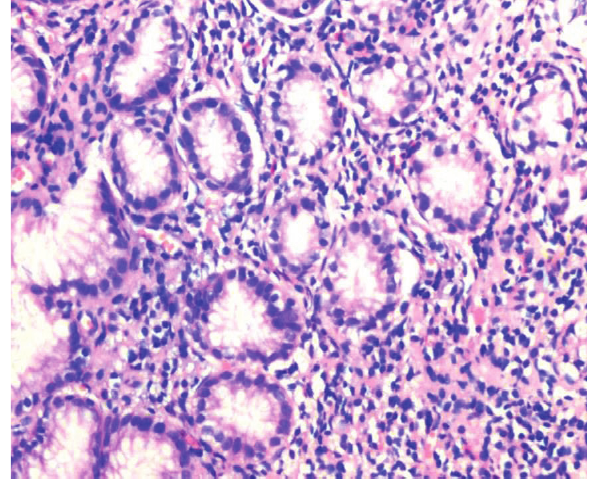
Fig-4: H&E Chronic Moderate antral Gastritis